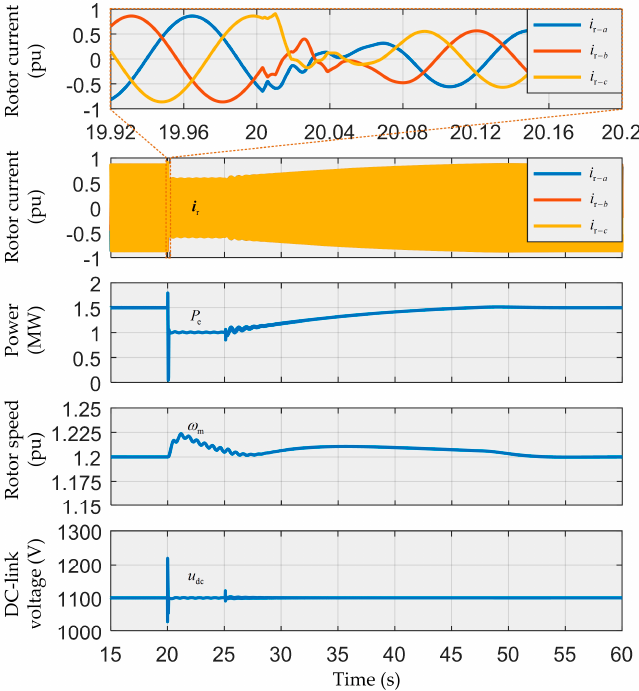
Figure 7. Major changes of electric and mechanical quantity at the wind turbine side in Scenario 1. Scenario 2. It is assumed that the B12 and B21 trip at 30 s under the control of FA when the wind speed is 10 m / s (DFIG MPPT operation). The islanding load is 0.8 MW, ∆ f = − 0.25 Hz, and ∆ θ = π ( 180 ◦ ) . T4 requires 60 ms to close. Figures 8 and 9 respectively show the changes in the electrical and mechanical quantity at the DN side and the wind turbine side in Scenario 2.